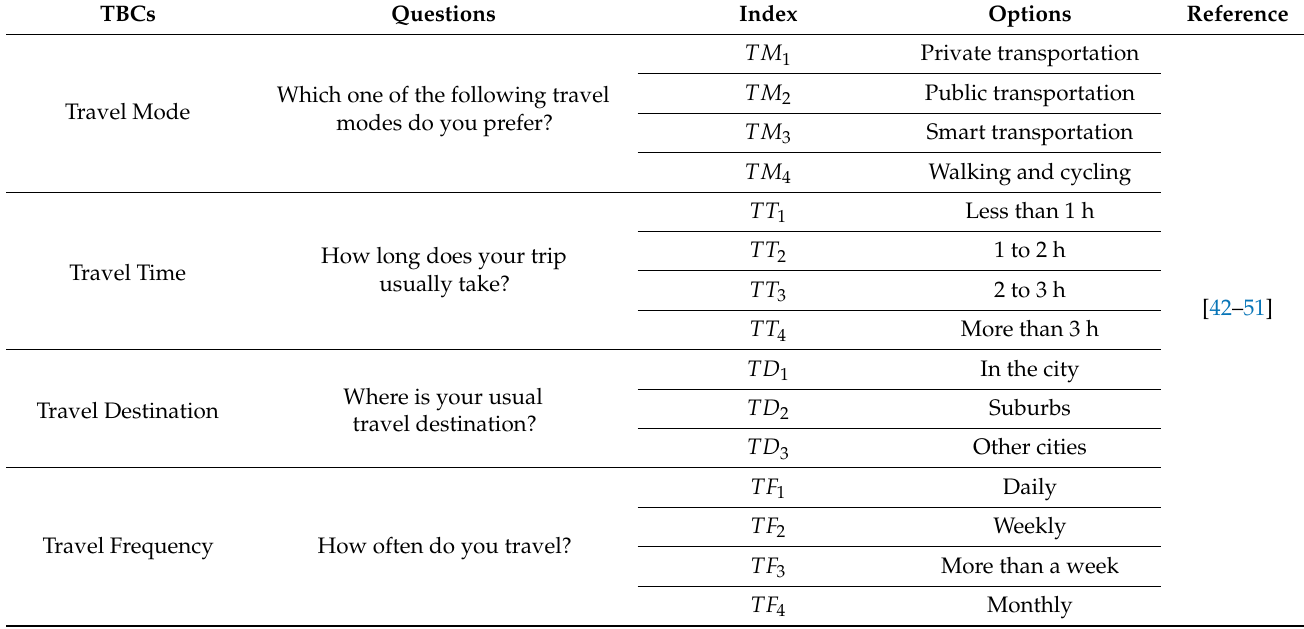
Table 2. Questionnaire containing components of travel